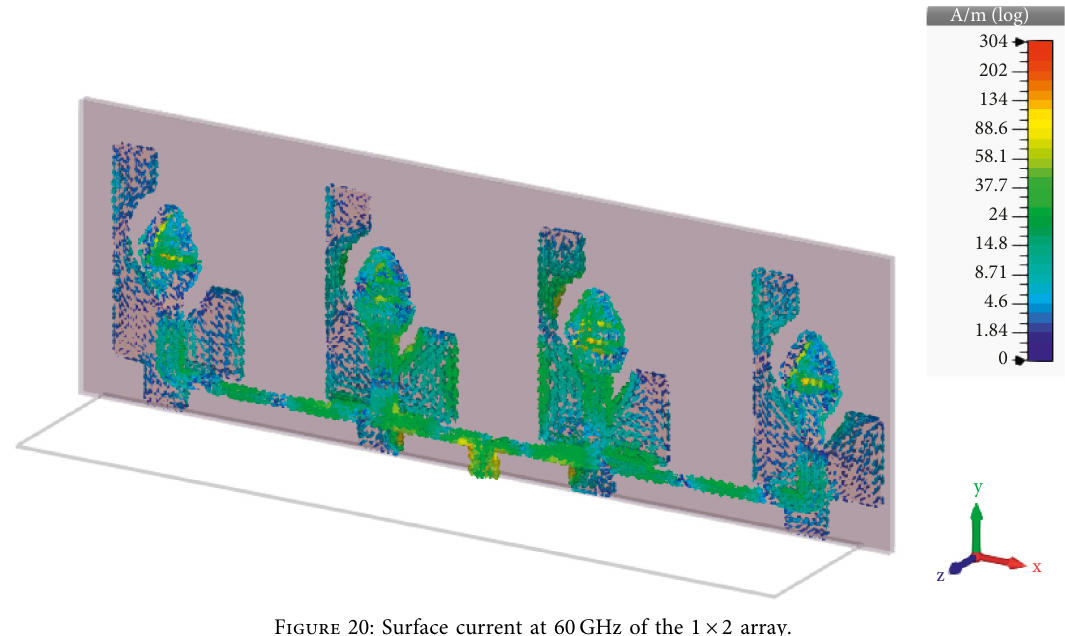
Figure 20: Surface current at 60GHz of the 1 × 2 array.